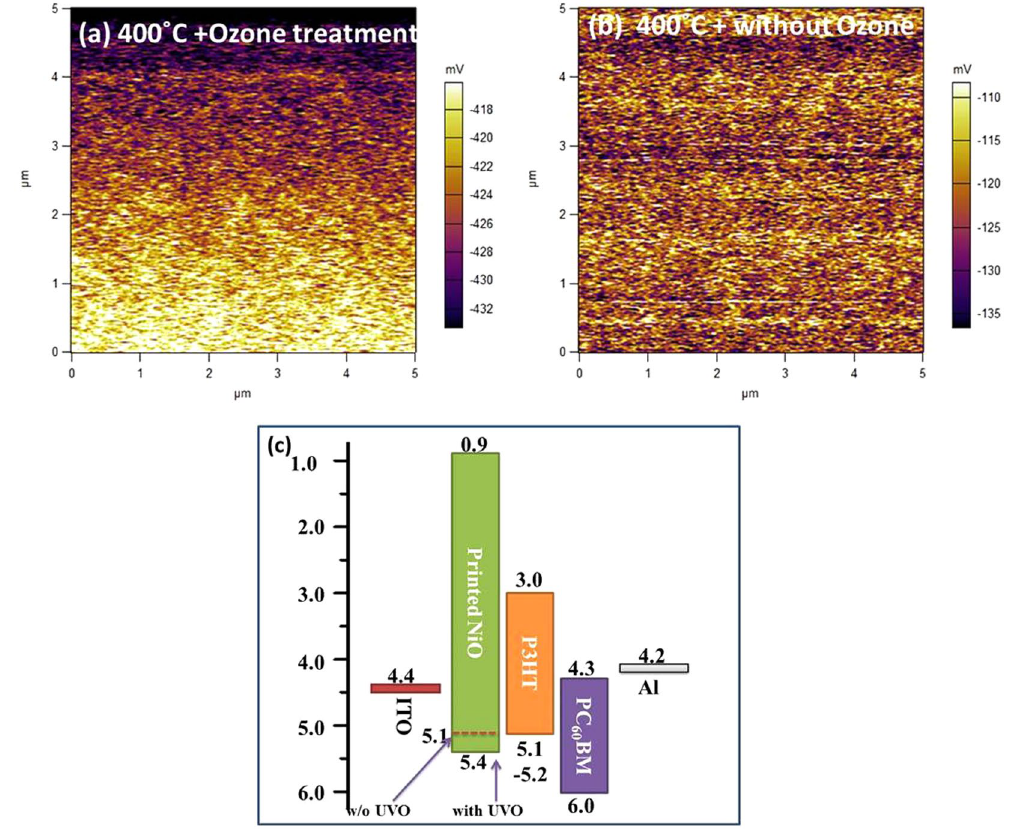
Figure 9. ( a ) and ( b ) KPFM contact potential difference maps of heat treated NiO films on ITO/glass substrates with and without ozone treatment of NiO film ( c ) Schematic energy band diagram of the device with NiO as HTL and P3HT:PC 60 BM active